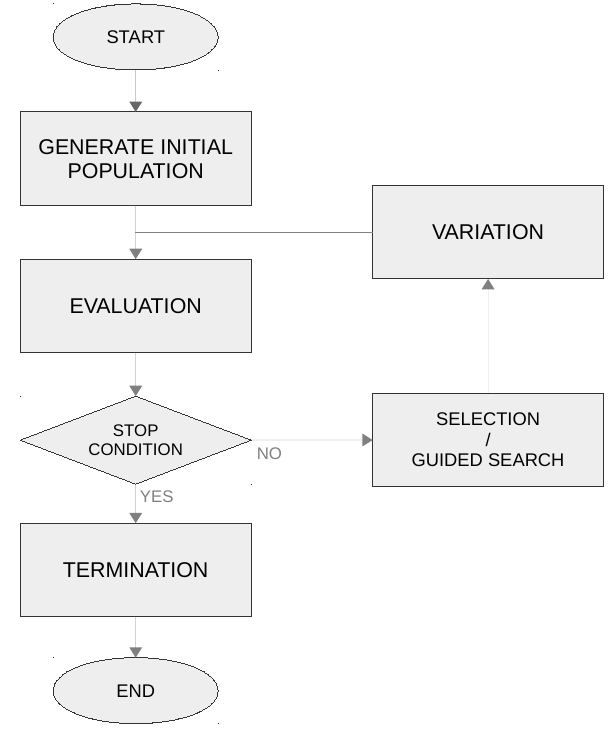
Figure 4. Basic flow chart of a general population-based